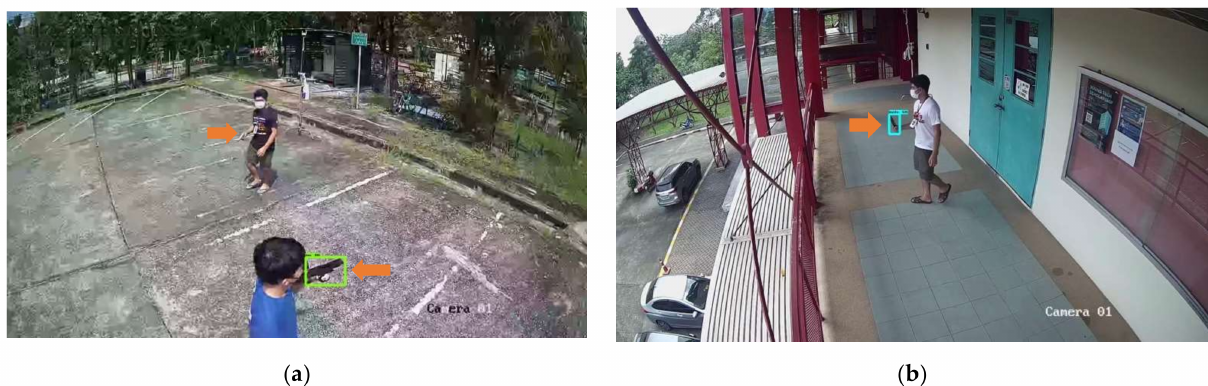
Figure 11. SSD MobileNet V2 model prediction on example images using ( a ) Test Dataset 1 and ( b ) Test Dataset 2.